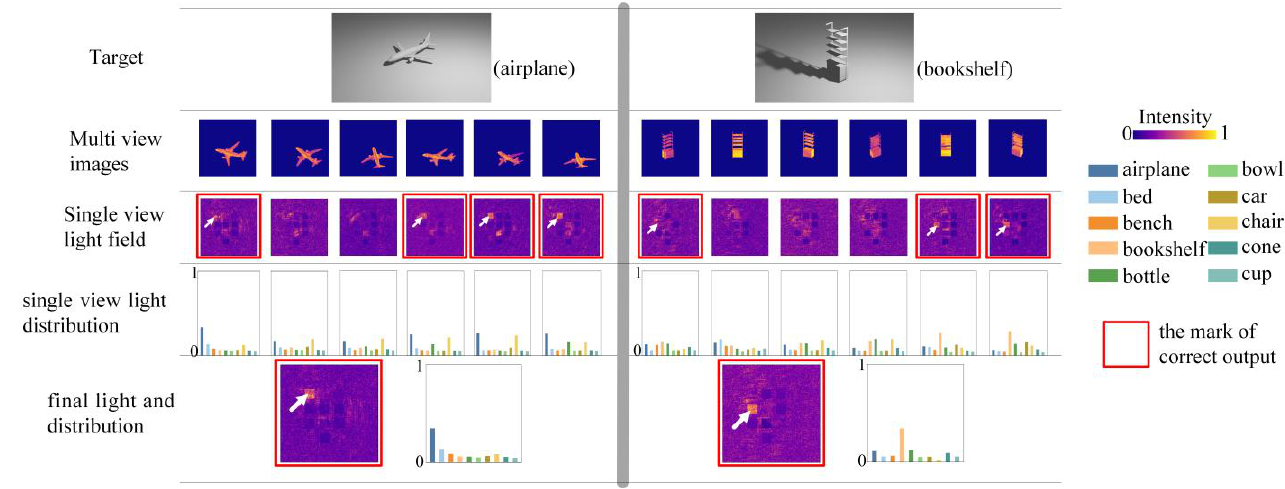
Figure 10. Detailed inference of the mr -MDA.